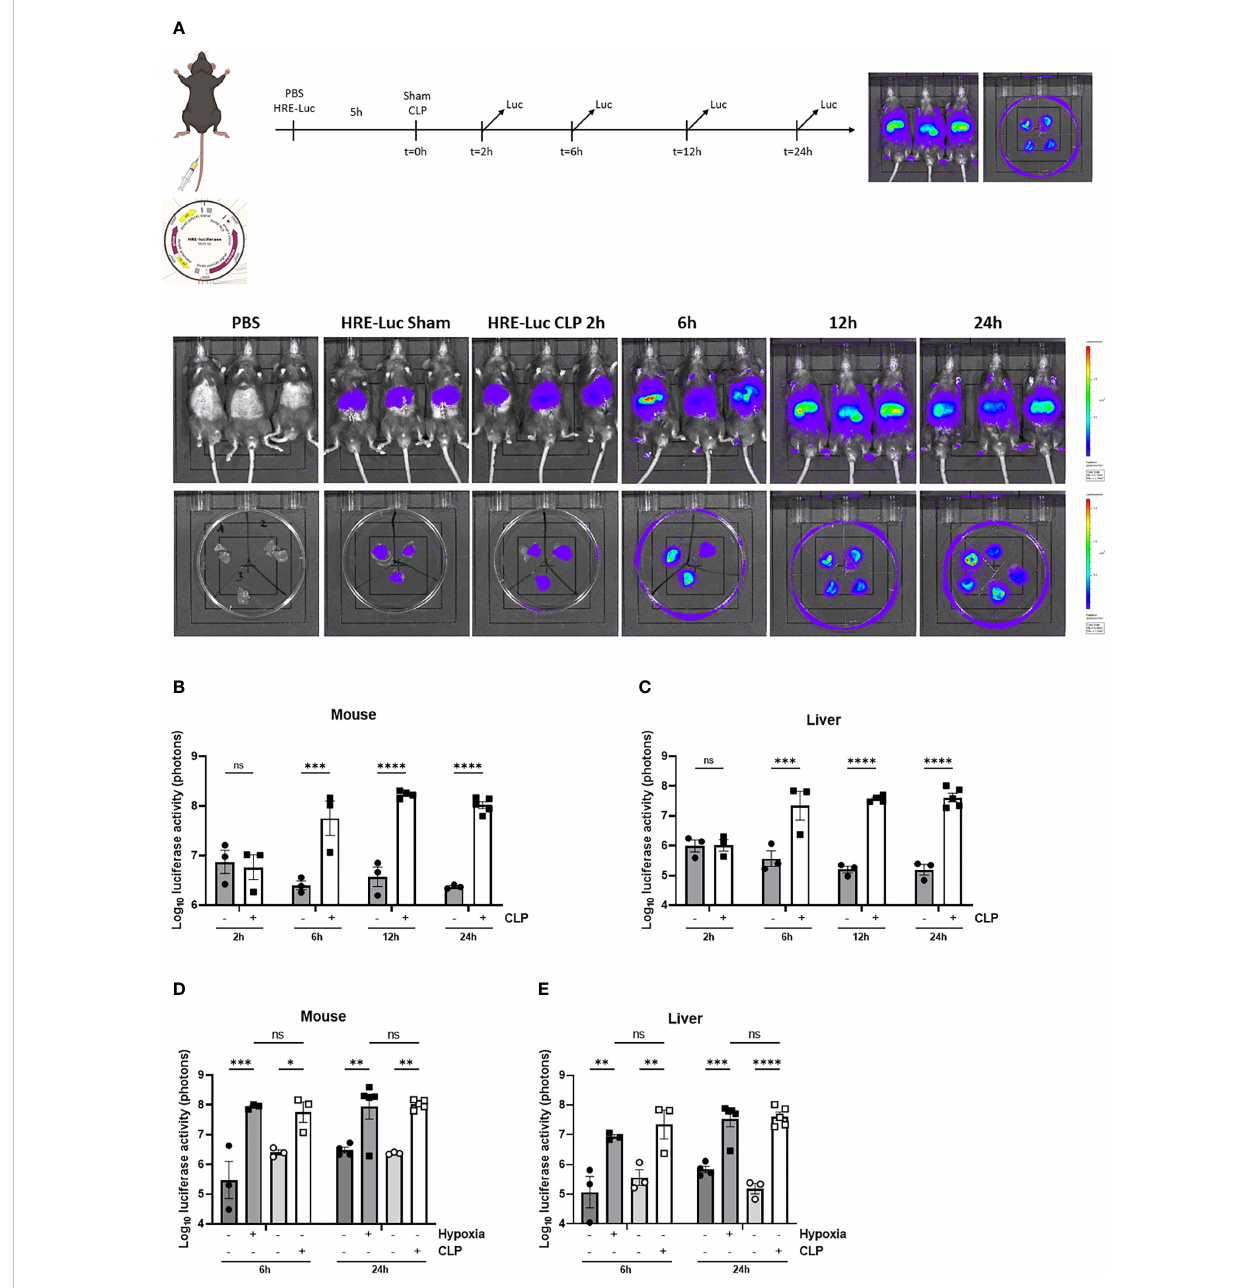
FIGURE 3 HIF activity in mouse liver during sepsis using high-pressure injections. (A-C) The effect of CLP on HIF activity was estimated in C57BL/6J mice by a HRE-luciferase reporter plasmid at indicated time points. All mice were injected according to body weight. (A) Experimental set-up and imaging of the luciferase activity (purple signal) in the liver of PBS control mice and mice after a sham or CLP procedure at the indicated time points. Log 10 of the bioluminescent photon counts normalized to the PBS control group of C57BL/6J mice (B) and their livers (C) subjected to a sham or CLP procedure at the indicated timepoints (n=3-5/group). Log 10 of the bioluminescent photon counts of mice (D) and their livers (E) subjected to normoxia (black circles) or hypoxia (black squares) and sham (white circles) or CLP (white squares) at the indicated time points (n=3-5/group). All bars represent mean ± SEM. Each individual data point represents individual mice. P-values were calculated using two-way ANOVA. **P ≤ 0.01; *P ≤ 0.05; ***P <0.001; ****P <0.0001. ns, non-signi fi